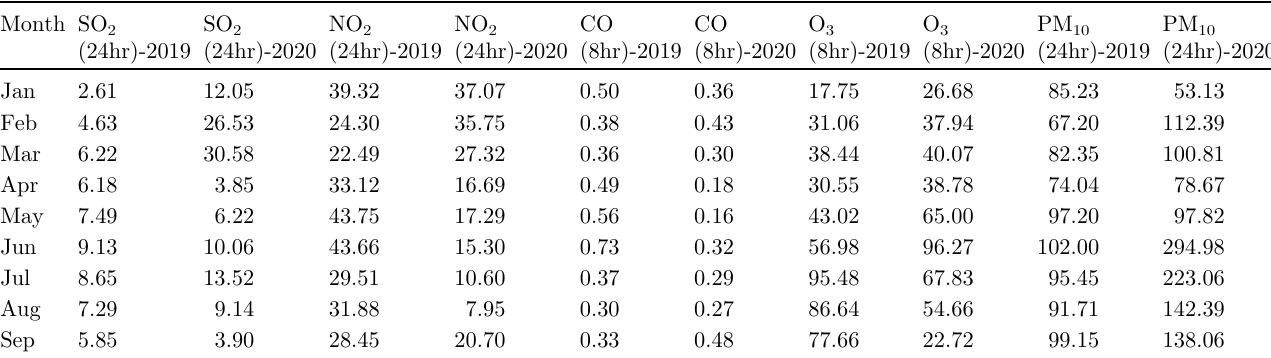
Table 3. The average data